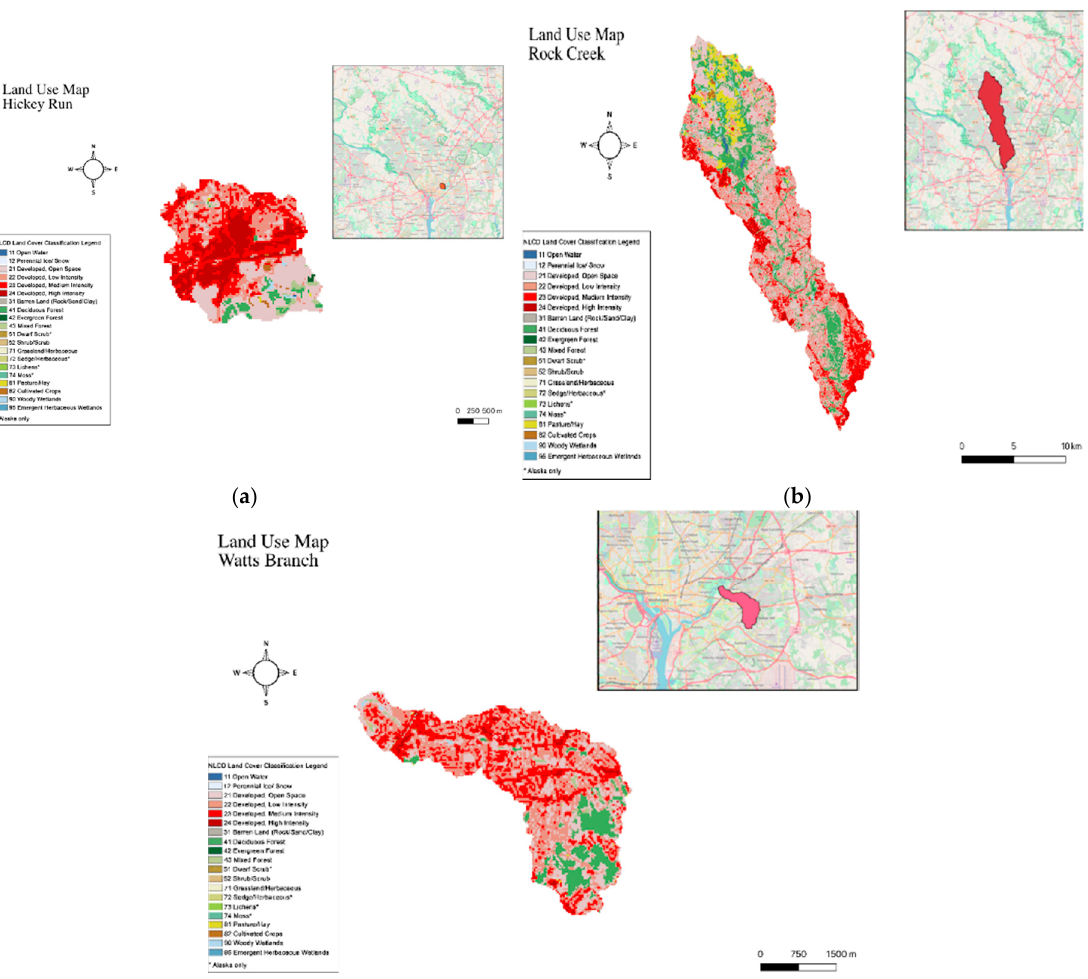
Figure 1. Land use for the Hickey Run ( a ), Rock Creek ( b ), and Watts Branch ( c ) watersheds.